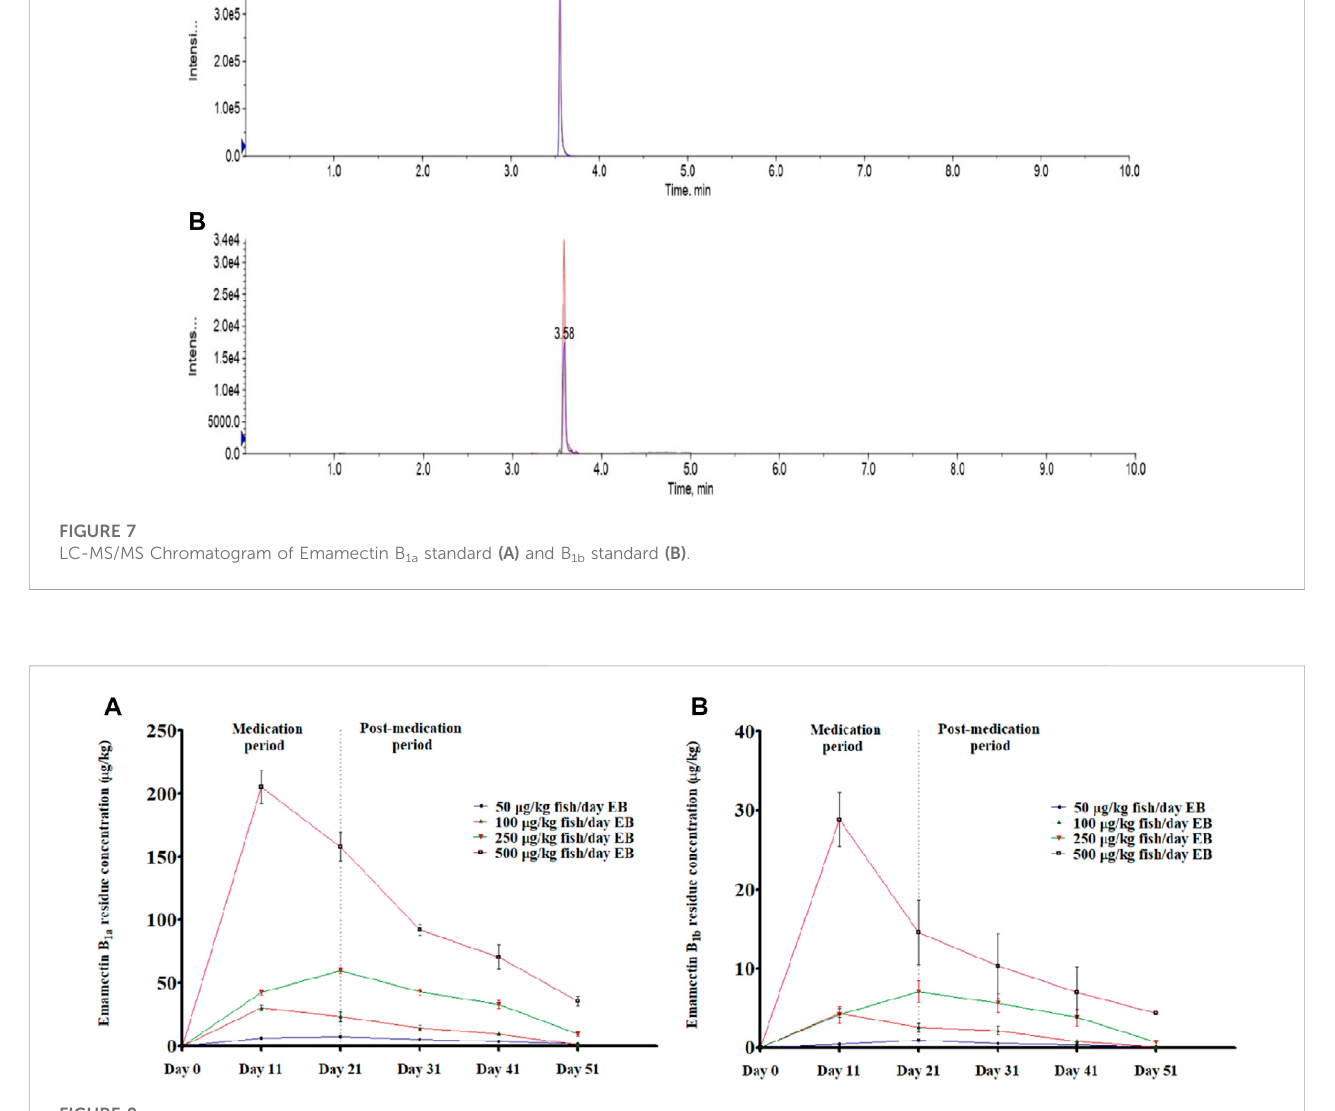
FIGURE 8 (A, B) : LC-MS/MS based residual analysis of EB metabolites (A) Emamectin B 1a and (B) Emamectin B 1b from muscle tissues of golden mahseer fed with different doses of EB, viz. , 1×: 50 μ g/kg fi sh/day; 2×: 100 μ g/kg fi sh/day; 5×: 250 μ g/kg fi sh/day and 10×: 500 μ g/kg fi sh/day for 21 days ( p < 0.05). The error bar shows the standard error mean